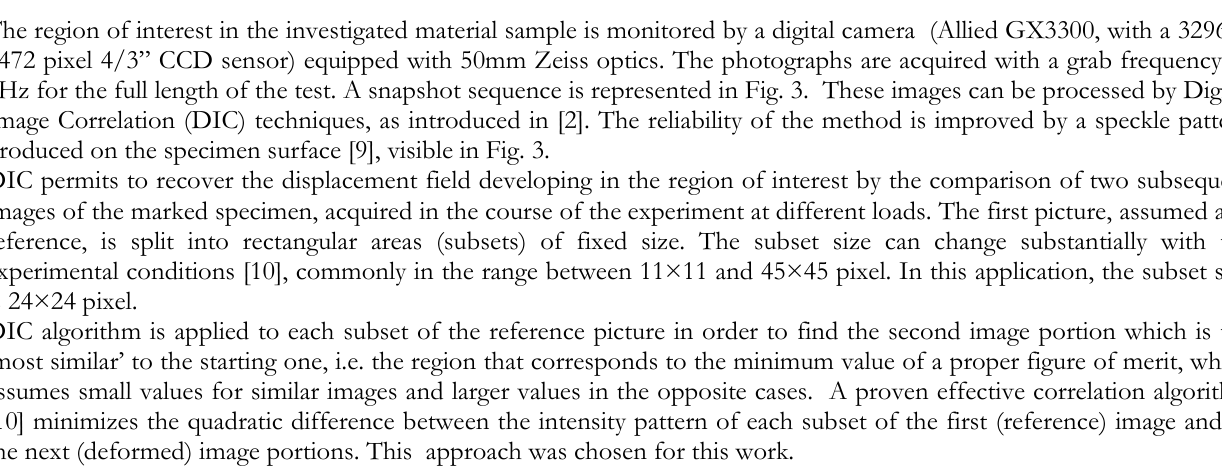
Figure 2: Force versus total specimen elongation in tensile test.